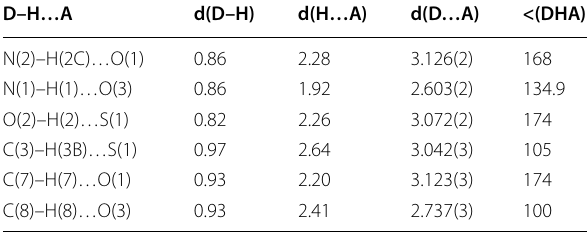
Table 3 Hydrogen bonds for isomer 1B [(Å) and (°)]